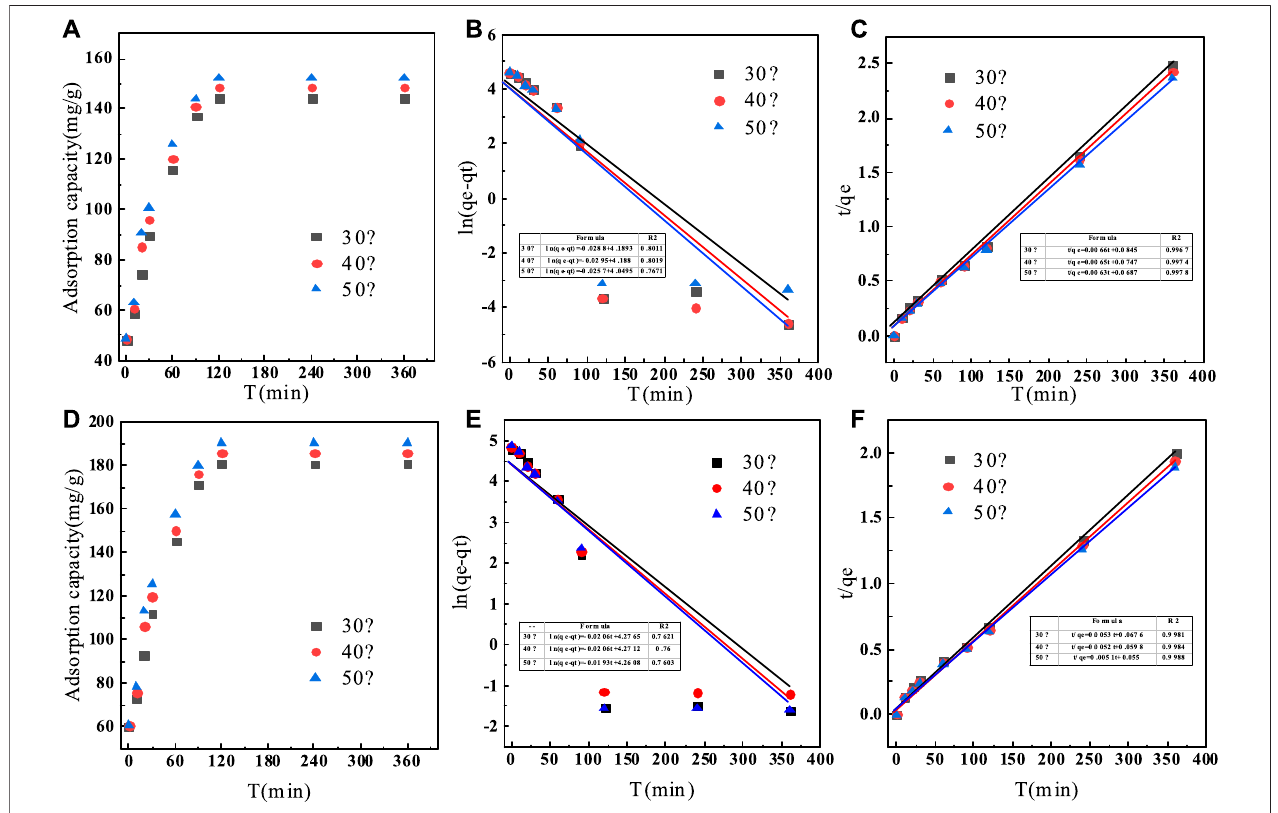
FIGURE 8 | (A) Adsorption kinetics of fl uoride on C-SAA; (B) the pseudo- fifi rst-order model on C-SAA; (C) the pseudo-second-order model on C-SAA; (D) adsorption kinetics of fl uoride on C-SAA oa ; (E) the pseudo- fifi rst-order model on C-SAA oa ; (F) the pseudo-second-order model on C-SAA oa .